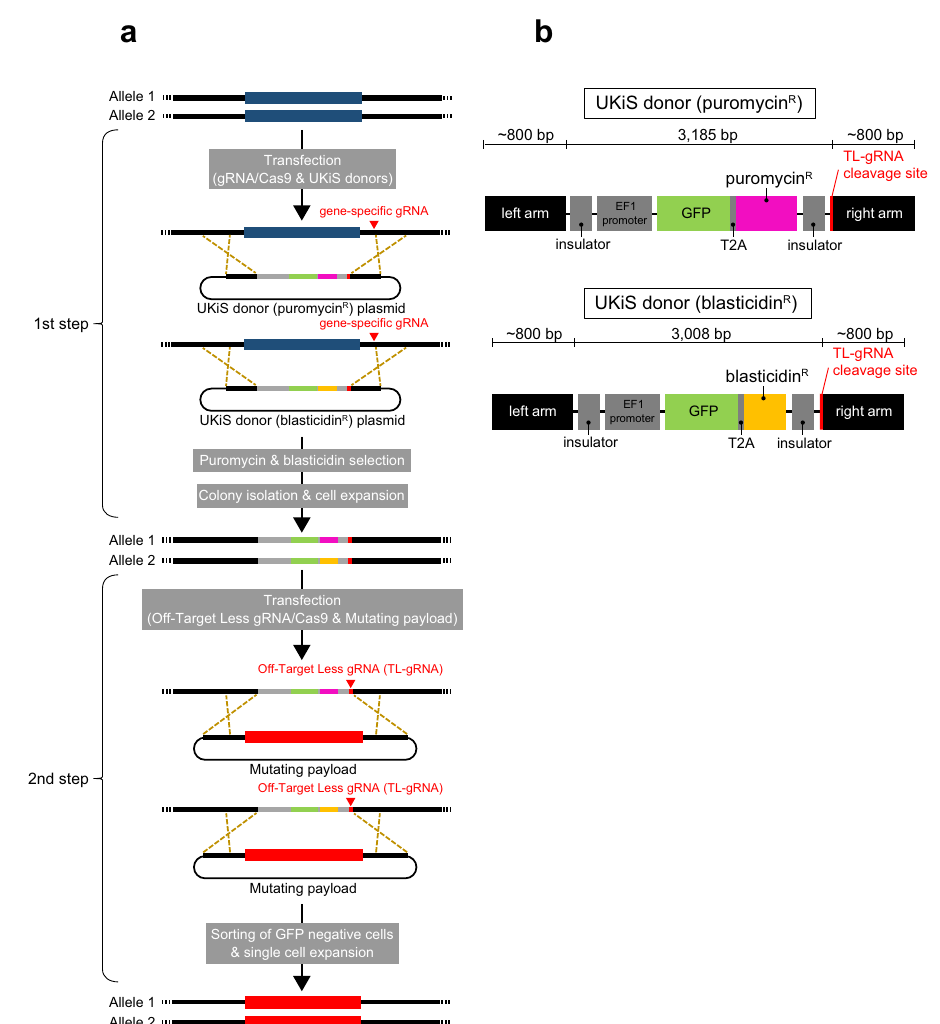
Fig. 1 Overview of UKiS. a The two-step process of UKiS. First step: co-transfection of the expression plasmid for Cas9 protein and the gene-speci fi c gRNA and the two UKiS donor plasmids, followed by puromycin and blasticidin selection, to collect cells that had undergone biallelic replacement of the target locus with UKiS marker sequences. Second step: co-transfection of the expression plasmid for Cas9 and the Off-Target Less gRNA (TL-gRNA) and the mutating payload plasmid containing the desired mutation, followed by fl uorescence-activated cell sorting (FACS) to collect cells that do not express GFP because UKiS marker sequences at both target alleles were replaced by the payload sequence. b Schematic illustration of the two UKiS donors. The UKiS donors consist of homology arms and insulators on both sides and, between them, a marker gene encoding a chimeric protein consisting of GFP and one of two antibiotic markers (puromycin or blasticidin), each of which is linked by a T2A self-cleaving peptide sequence. The sequence corresponding to TL- gRNA 12 partially overlaps with the right arm of the donor